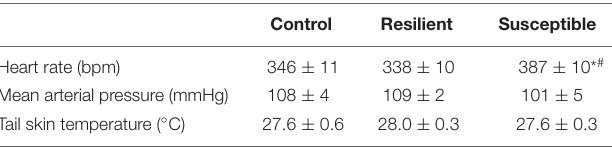
TABLE 2 | Resting heart rate, mean arterial pressure, and tail skin temperature of resilient and susceptible phenotypes to SDS. Control Resilient Susceptible